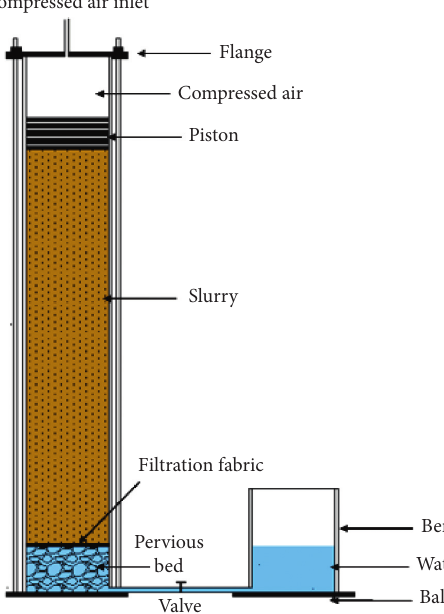
Figure 3: Schematic diagram of the slurry filter press.